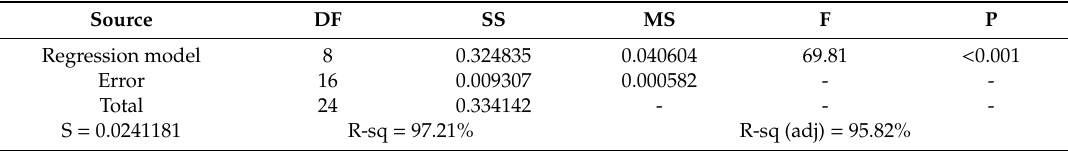
Table 7. ANOVA results for the GRG model.